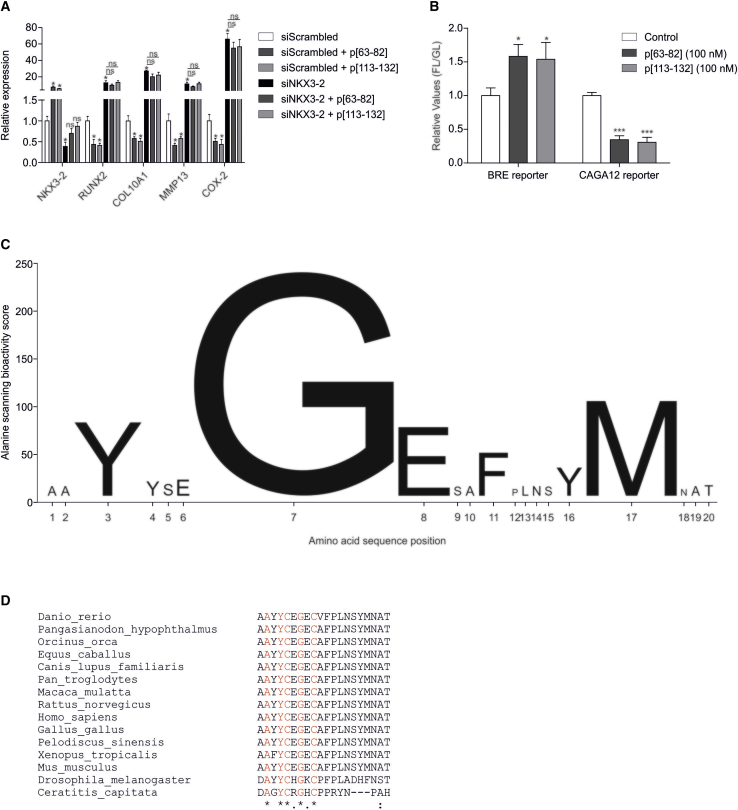
Molecular characterization of peptides p[63−82] and p[113−132](A) A pool of OA-HACs (n = 4 donors) was transfected with a scrambled siRNA or with an NKX3-2 siRNA (100 nM siRNA) and cultured for 24 h. Cultures were then exposed to peptide p[63−82] or p[113−132] (100 nM peptide). Samples were harvested 24 h later and analyzed for the expression of the indicated mRNAs (normalized to 28S rRNA). (B) SW1353 chondrocytic cells were transfected with BRE (SMAD1/5/8 reporter) or CAGA12 (SMAD2/3 reporter) firefly luciferase-reporter plasmids. A CMV-Gaussia plasmid was cotransfected as a transfection control. Cells were then cultured for 24 h and subsequently exposed to control, p[63−82], or p[113−132] for 8 h. Firefly and Gaussia bioluminescence were measured in cells and medium (respectively), and relative light units (RLUs) of firefly luciferase were normalized for the Gaussia luciferase signal. The normalized firefly luciferase signal of the control condition was set at 1, and peptide conditions were calculated relative to the control condition (FL/GL). Error bars represent mean ± SEM; statistical significance for peptide conditions versus siScrambled or siNKX3-2 (A) or control condition (B) as determined by unpaired two-tailed Student’s t test is represented as ∗p < 0.05, ∗∗p < 0.01, and ∗∗∗p < 0.001. (C) An alanine scanning library of peptide p[63−82] was synthesized, and the pool of 18 OA-HACs originally used for the full library scanning (Figure 1) was exposed to individual peptides from the alanine scanning library (100 nM peptide) for 24 h. An alanine-scanning bioactivity score (sum of the fold change gene expression of COL10A1, ALPL, MMP13, and COL2A1 plus NKX3-2 of the alanine-substituted peptides versus the wild-type p[63−82] peptide) was calculated for each alanine substitution in the amino acid sequence of peptide p[63−82] and is represented by the height of each letter on the y axis (data in Figure S4). (D) Multiple sequence alignment of the human BMP7 p[63−82] peptide with the homologous region in BMP7 of other species.